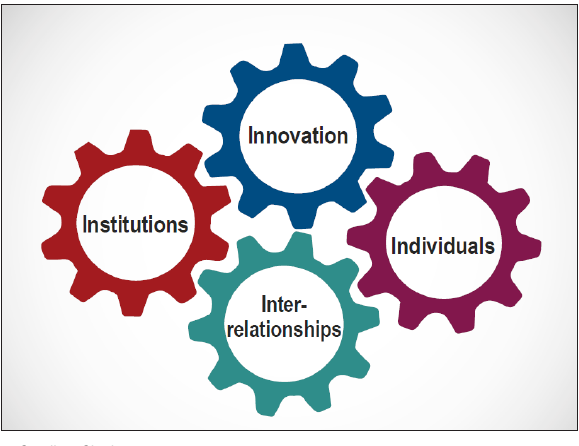
Figure 1: The gear-like nature of the 4I